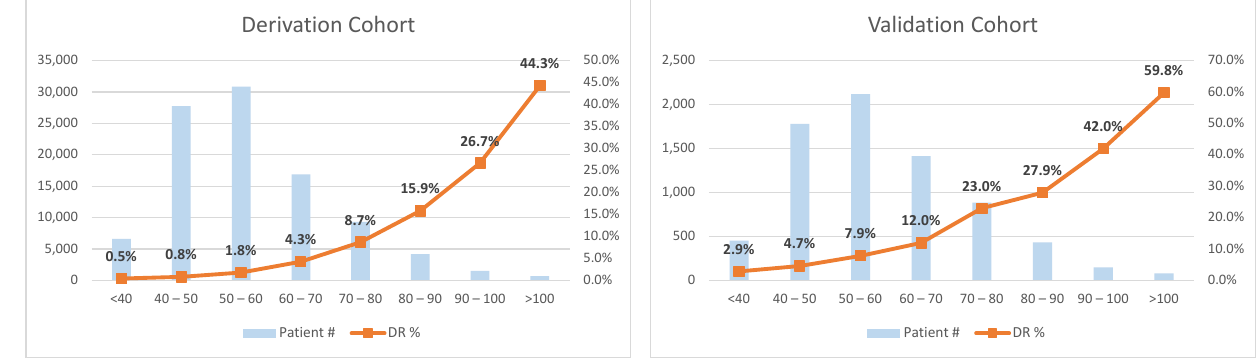
Figure 6. Risk index distributions in the cohorts.